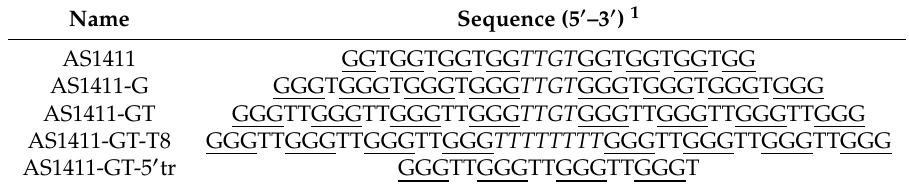
Table 1. List of the investigated G-quadruplex-forming guanine-rich oligonucleotides (GROs).